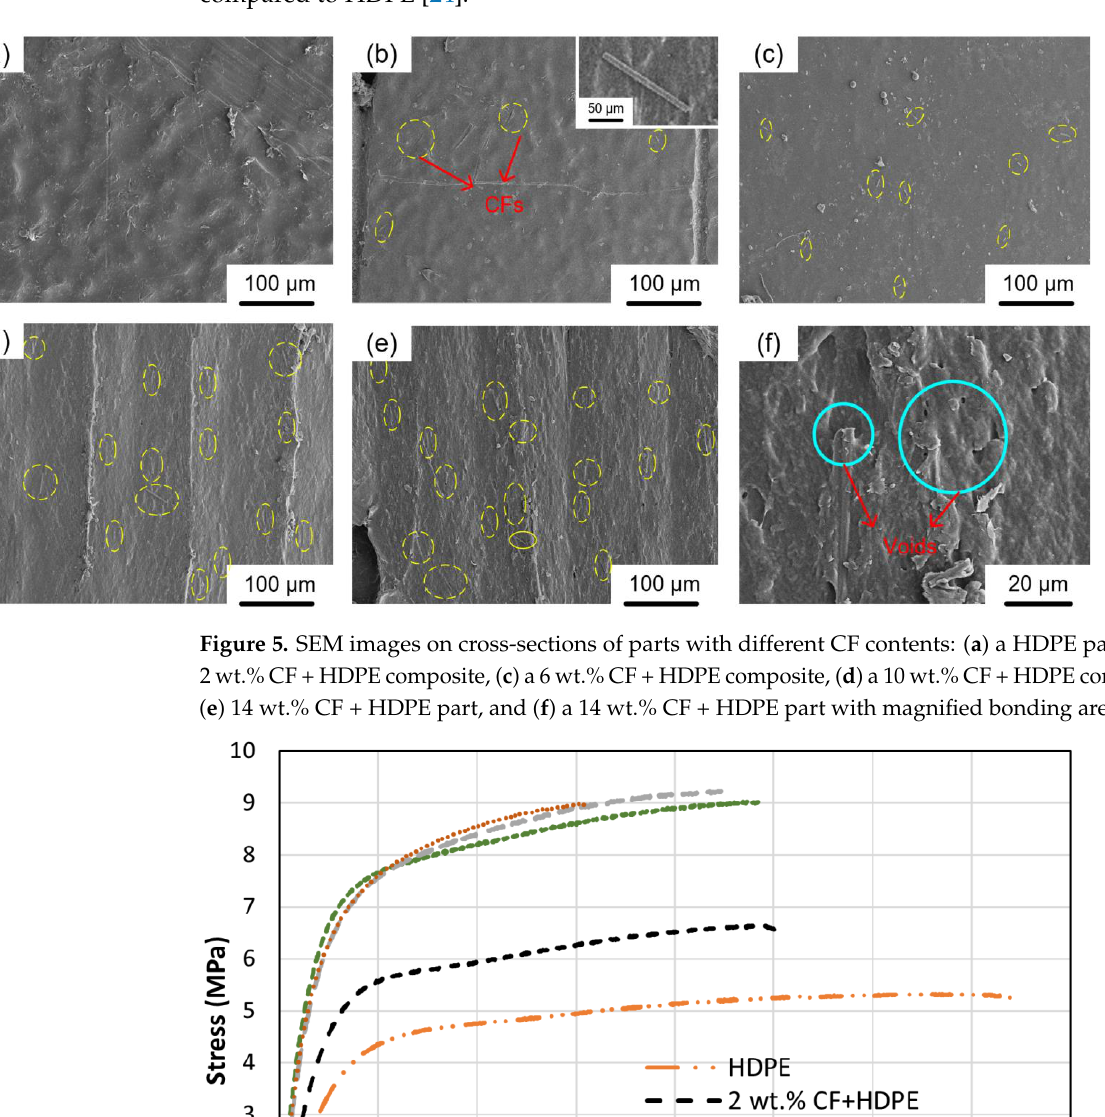
Table 3. A summary of tensile properties.